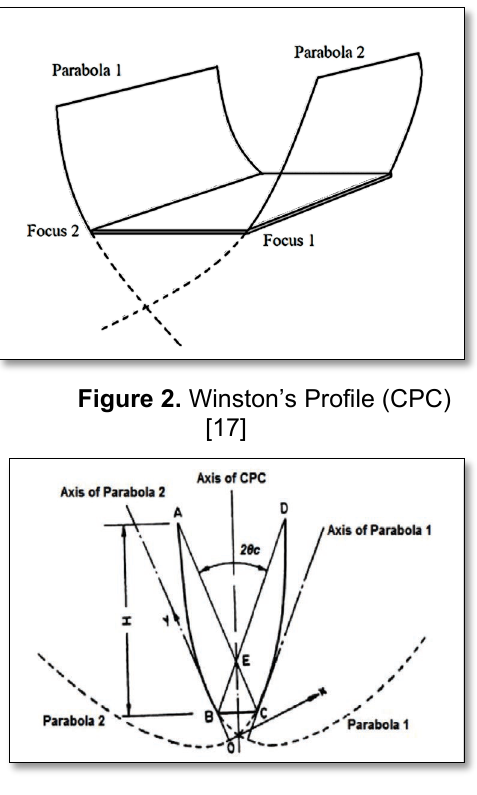
receiver (length of BC) are both made of same dimension.